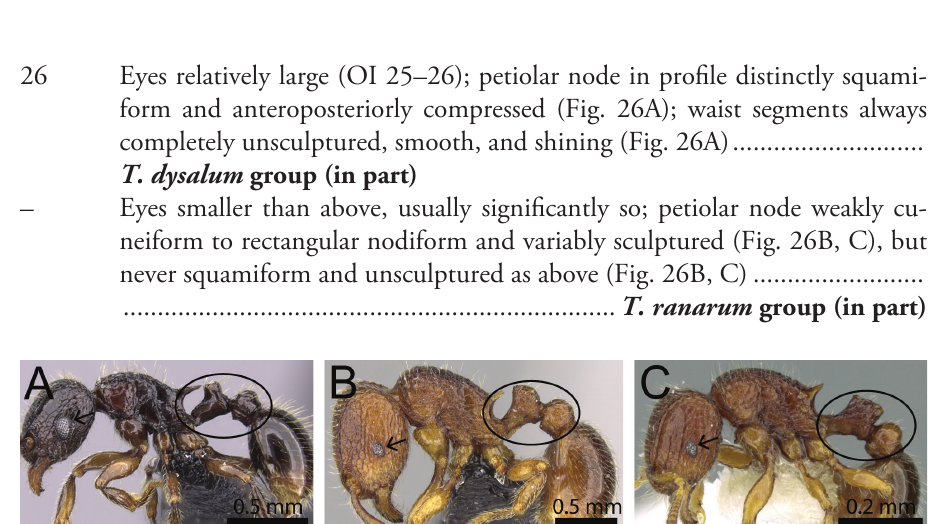
Figure 25. Mesosoma in dorsal view. A T. ambatovy (CASENT0124721) B T. quasirum (CASENT0102353) C T. coillum (CASENT0235219) D T. isectum (CASENT0172829) E T. steinheili (CASENT0102394) F T. alperti (CASENT0042547).